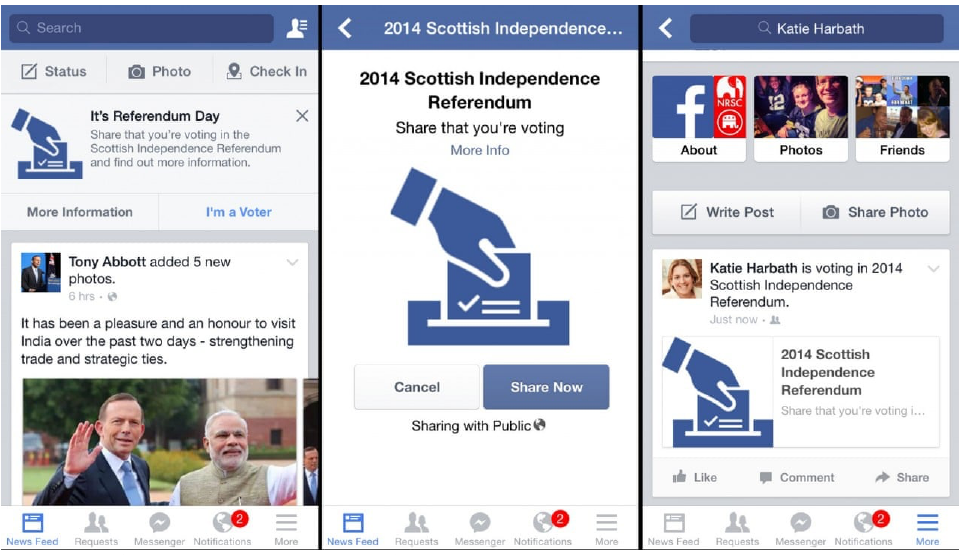
Figure 4: 2014, Scotland (Grassegger,